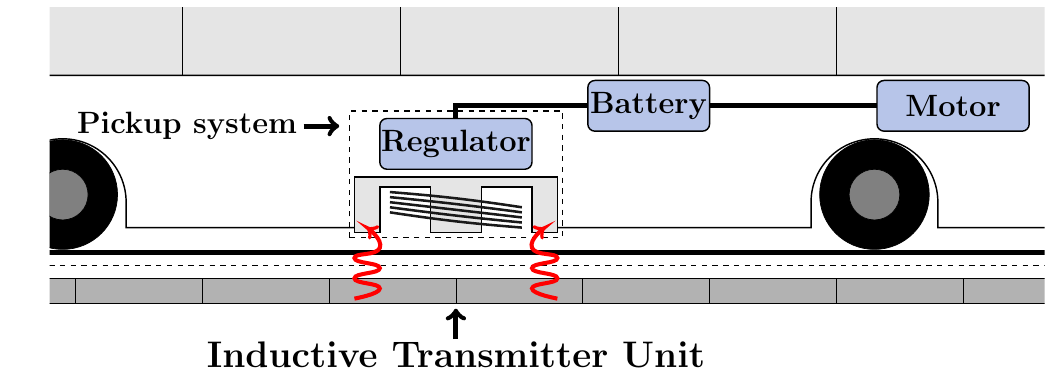
Figure 6. Dynamic wireless